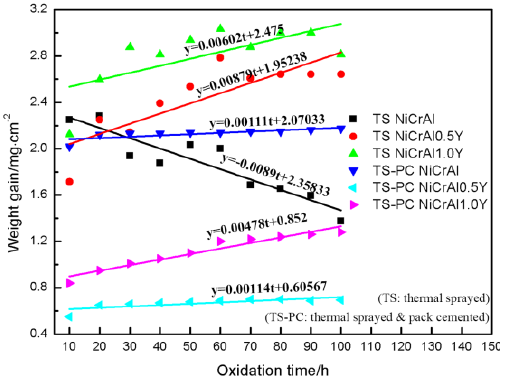
Figure 10. Fitting curve of coating oxidation weight gain when oxidation time is 10~100 h.